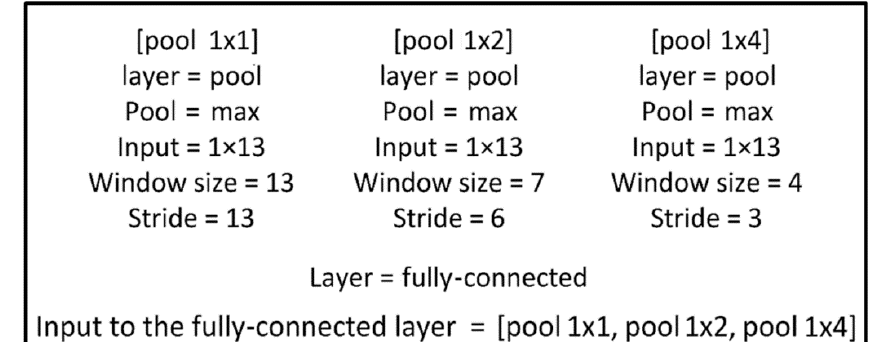
Figure 1. SPP layer in feature-vector processing.